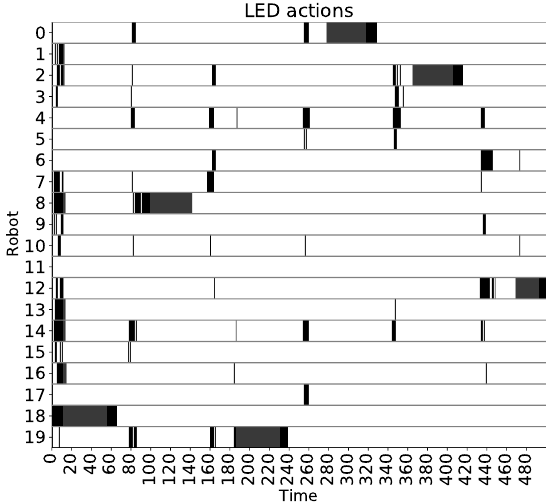
Figure 7. LED actions of the robots in a swarm of size 20 as time elapses in the leader selection experiment with leader failure. Horizontal black bars denote that the LED is